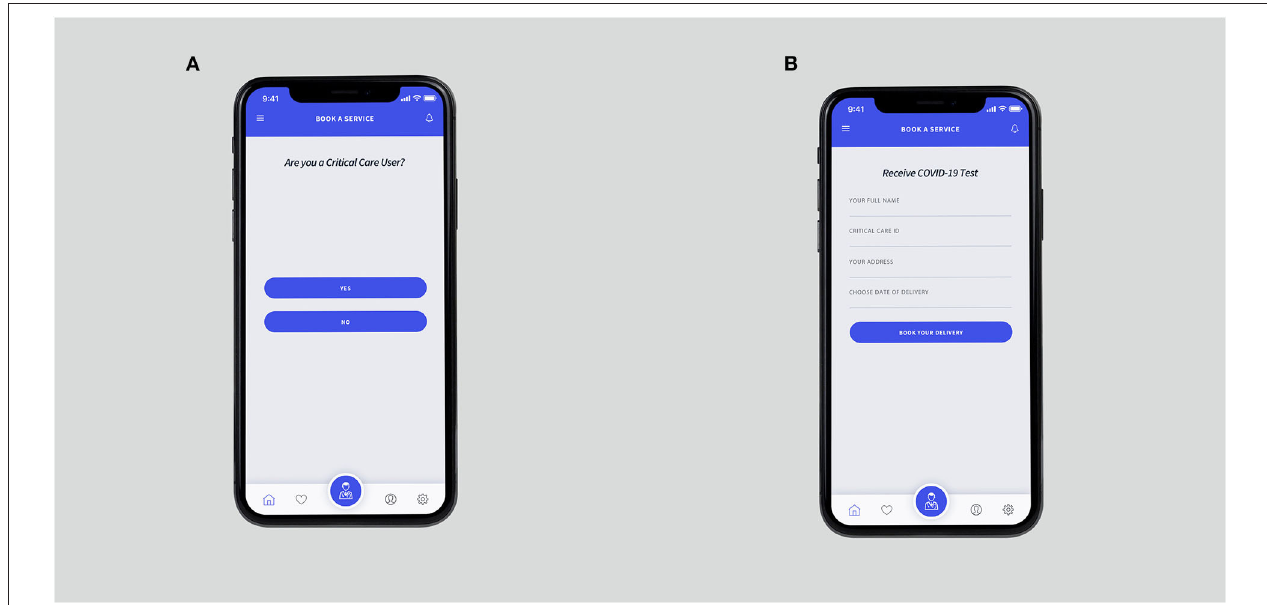
FIGURE 12 | (A) Service request segregating CCU users as a distinct subset. This step helps prioritize job requests sent to the service providers. (B) The encrypted form for requesting a COVID-19 test to be delivered at home. NHS transport volunteers can deliver the kits when the request is generated.